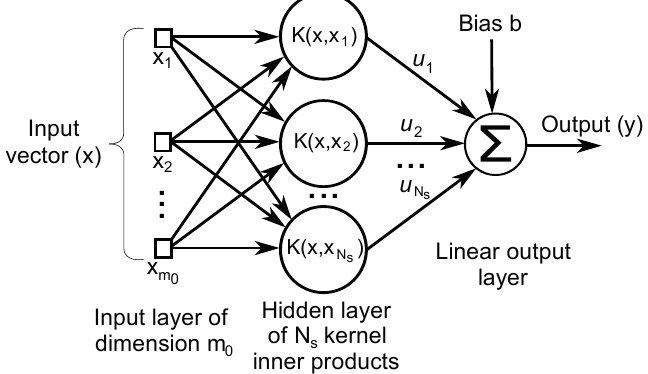
Figure 3. Architecture of a Support Vector Machine classifier. Inner product kernels, -dimensional kernel inner product of the input vector with each of the (cid:1837)(·,·) , denote the (cid:1865) (cid:2868) Support (cid:1840) (cid:3046)